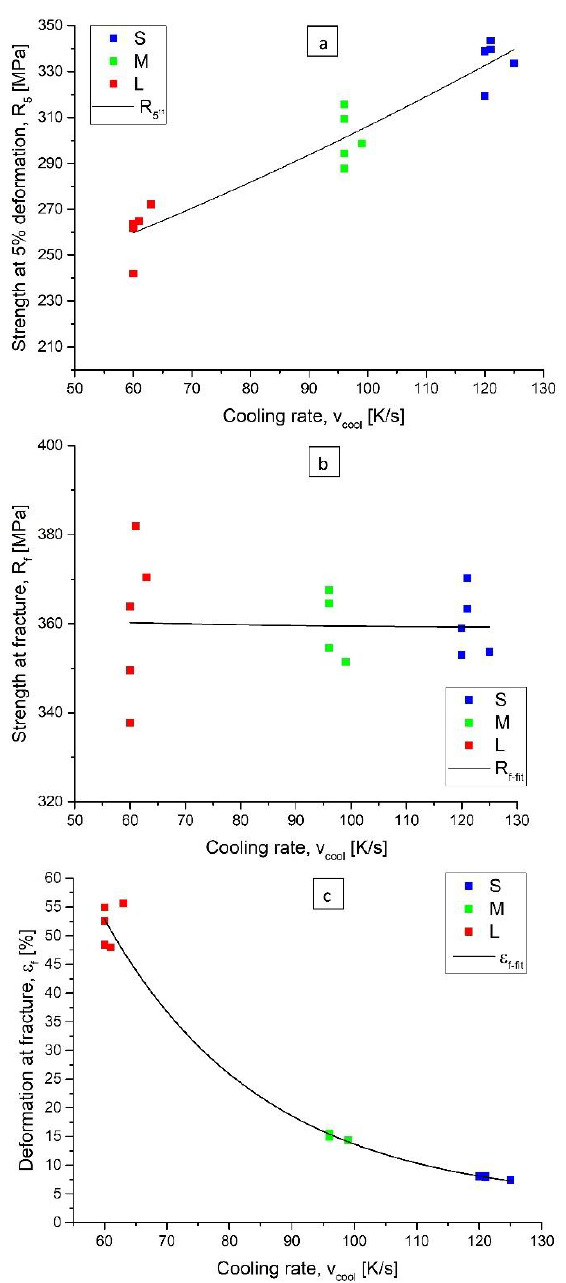
Figure 8. Diagrams of: ( a ) strength achieved after a total of elastic and plastic deformation of 5%, results as a function of cooling rate; ( b ) strength at fracture (or first significant crack formation), results as a function of cooling rate; and ( c ) deformation at R f , results as a function of cooling rate. Comparing the results of the SDAS measurements with the mechanical properties from the compression tests, it can be seen how the distance between the secondary dendrite arms decreased with increasing cooling rate and the mechanical properties increased